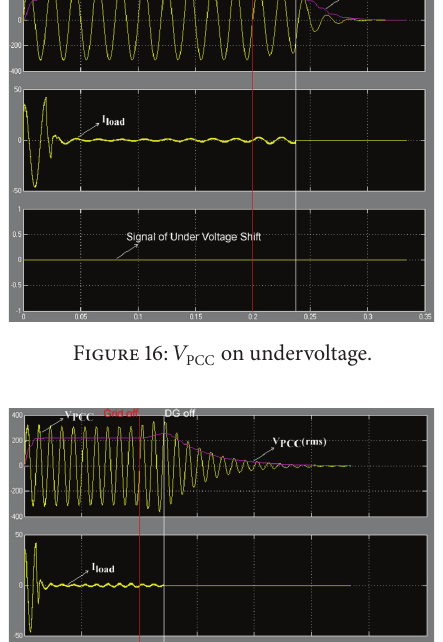
on overvoltage. PCC